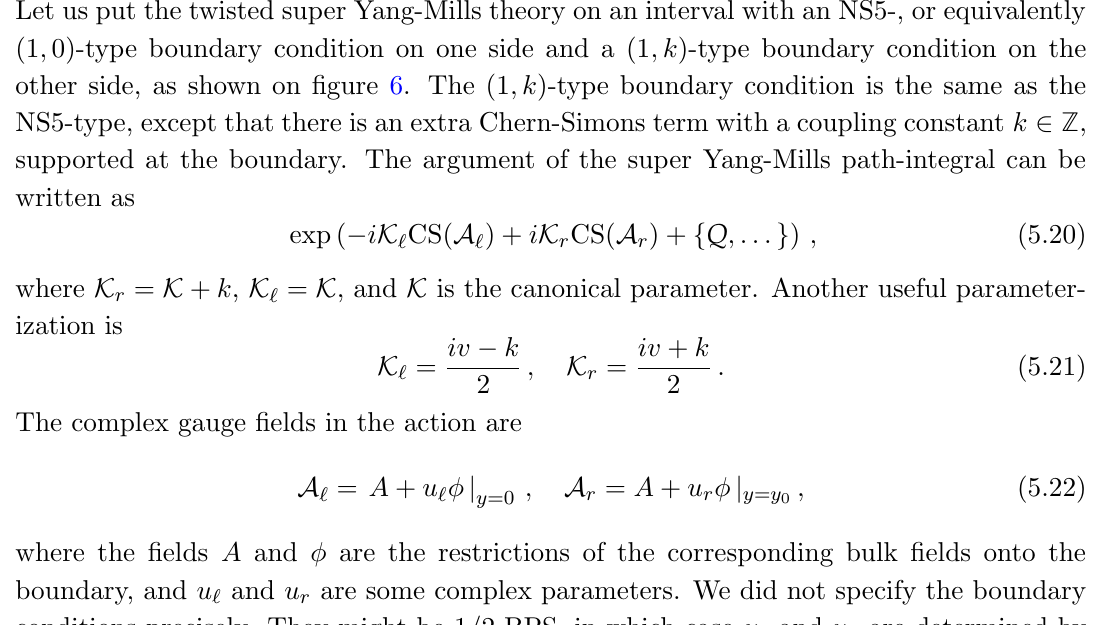
Figure 6 . The topologically-twisted N = 4 super Yang-Mills on an interval with an NS5 boundary condition on one side and a (1 ; k ) boundary condition on the other side is equivalent to a complex Chern-Simons theory with the integer level k and the complex coupling related to the canonical parameter K